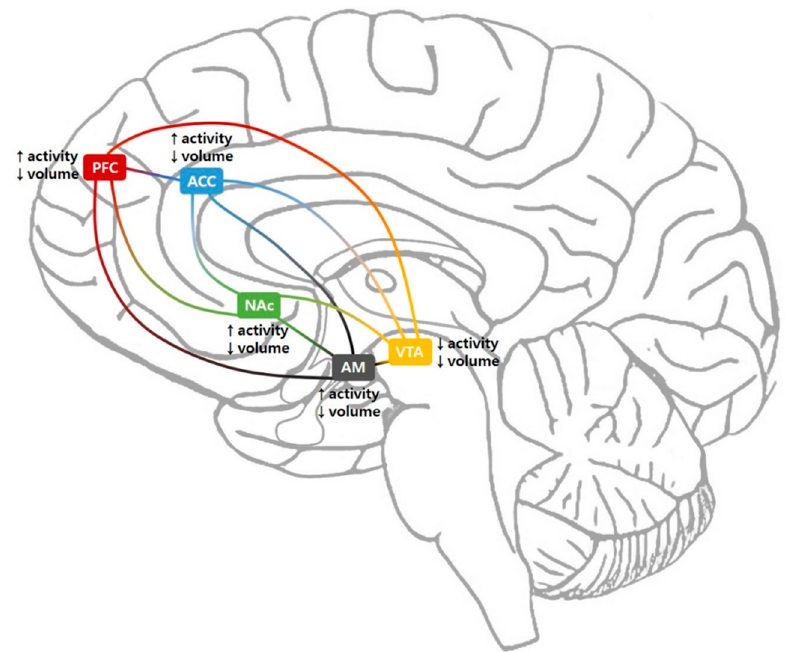
Figure 2. Structural and functional changes within the mesolimbic circuitry in patients with chronic pain. ACC, anterior cingulate cortex; AM, amygdala; NAc, nucleus accumbens; PFC, prefrontal cortex; VTA, ventral tegmental area.